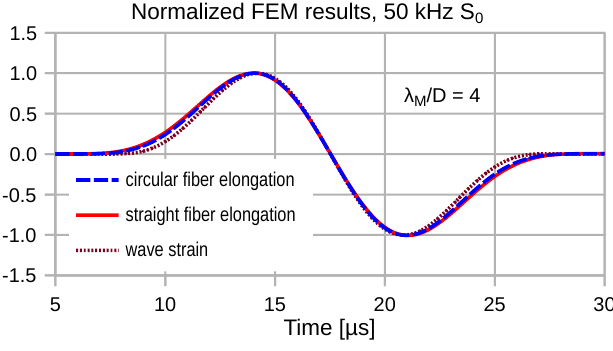
Figure 7. Low frequency transduction of plane wave strain by a circular and a straight fiber optic transducer. The fiber extent D is λ M /4 with λ M = v PH / f 0 .